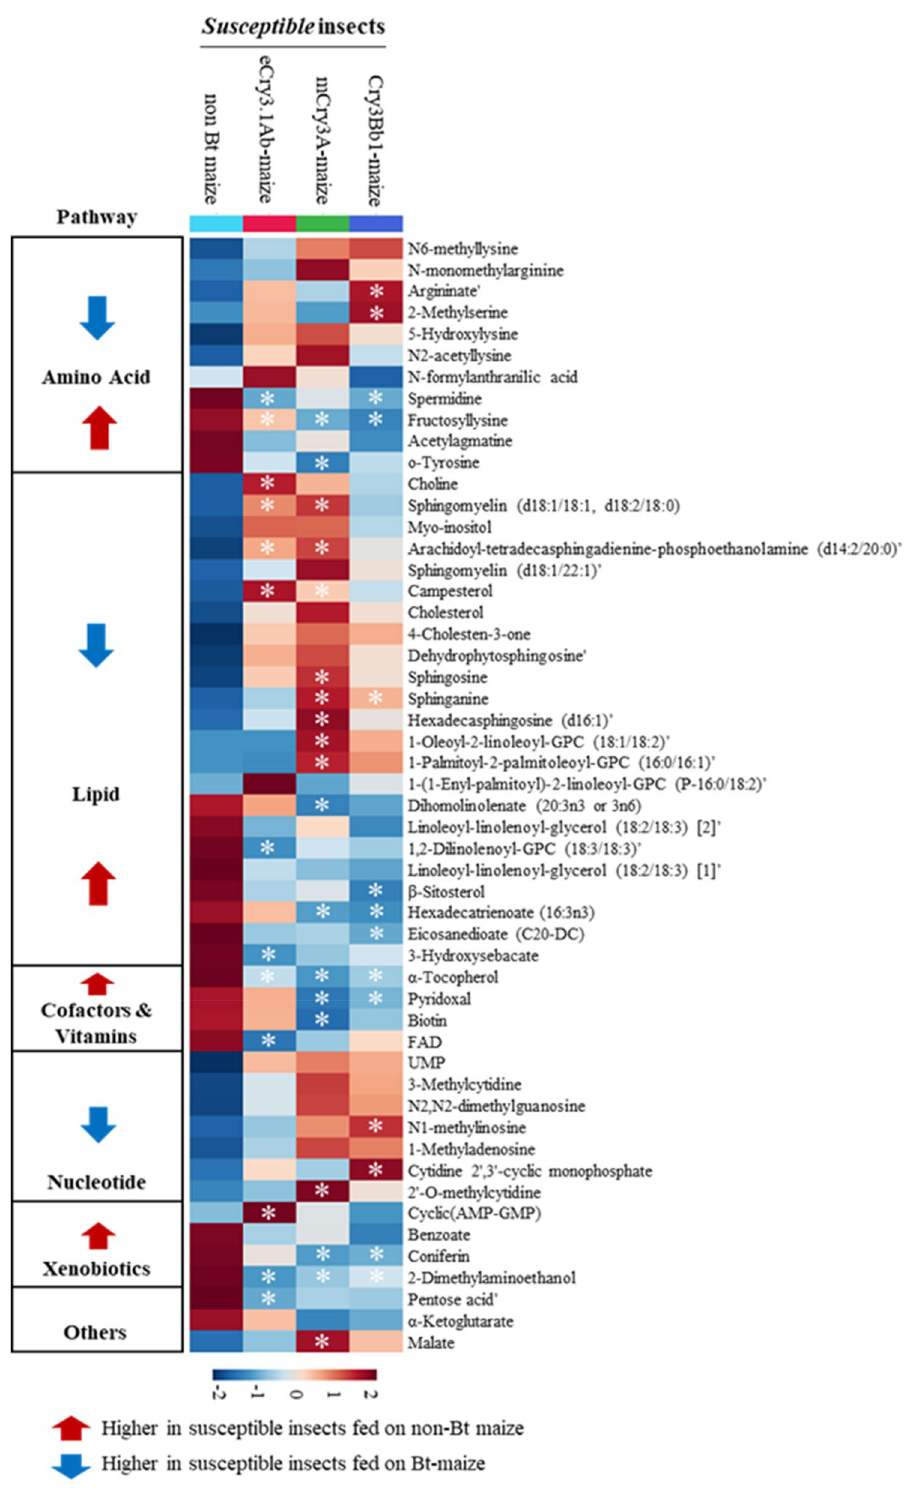
Figure 2. Heatmap representing differences in the levels of identified metabolites expressed differently in WCR susceptible larvae fed on control non-Bt maize compared with those fed on eCry3.1Ab-, mCry3A-, or Cry3Bb1- expressing maize seedlings. The metabolite annotation was confirmed with authentic standards, expected for the metabolites followed with (’) that were annotated based on their available identities (e.g., m/z , mass spectra). Asterisks (*) represent significant differences (p < 0.05) of metabolites in the susceptible insects fed on Bt maize compared with those fed on the non-Bt